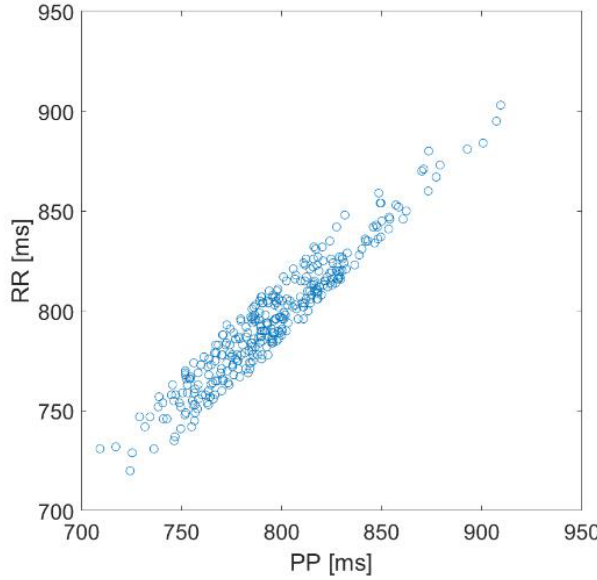
Figure 2. IBI values obtained by a synchronous acquisition of ECG and PPG signals; two minutes acquisition. PP: IBI value derived from PPG; RR: IBI value derived from ECG. acquisition. PP: IBI value derived from PPG; RR: IBI value derived from